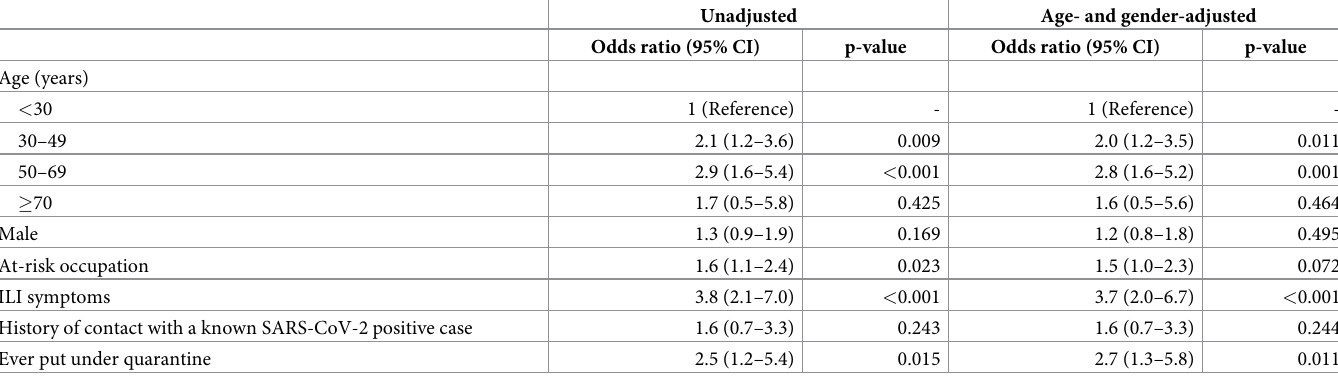
Table 5. Unadjusted and age- and gender-adjusted odds ratio of seropositivity by participant